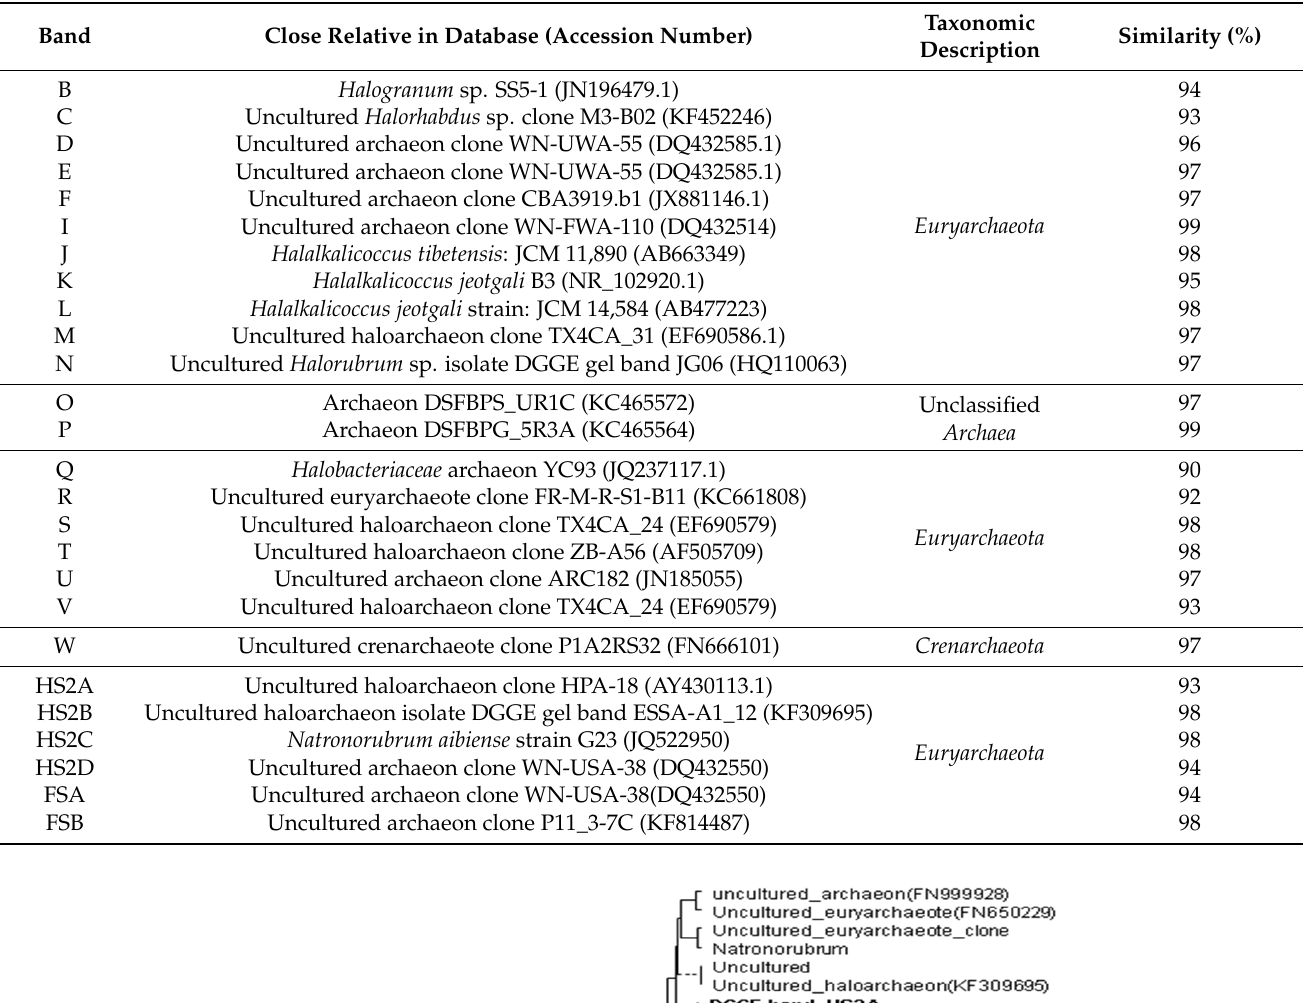
Table 4. Blast results of archaeal 16S rRNA sequences obtained from DGGE analysis.